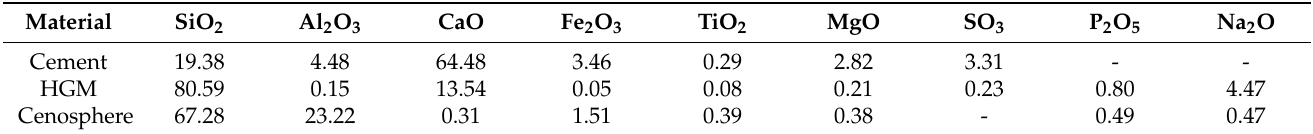
Table 1. Chemical composition of raw materials (mass%).